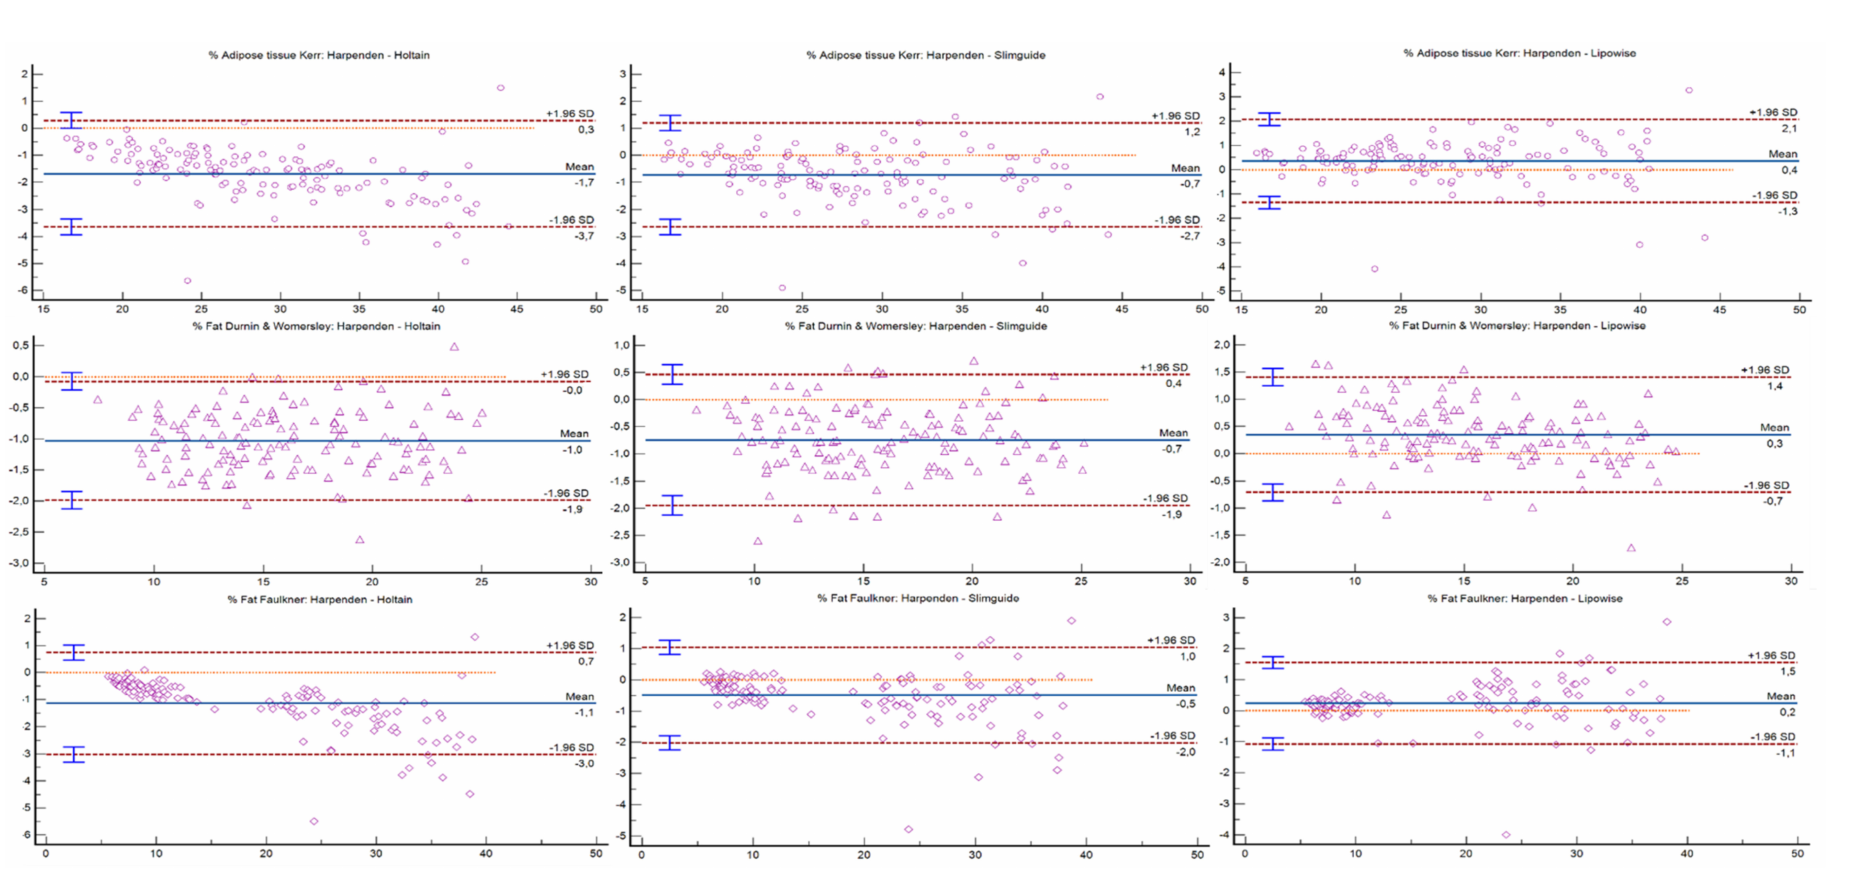
Figure 2. Bland–Altman plot for the percentage of adipose tissue and fat mass